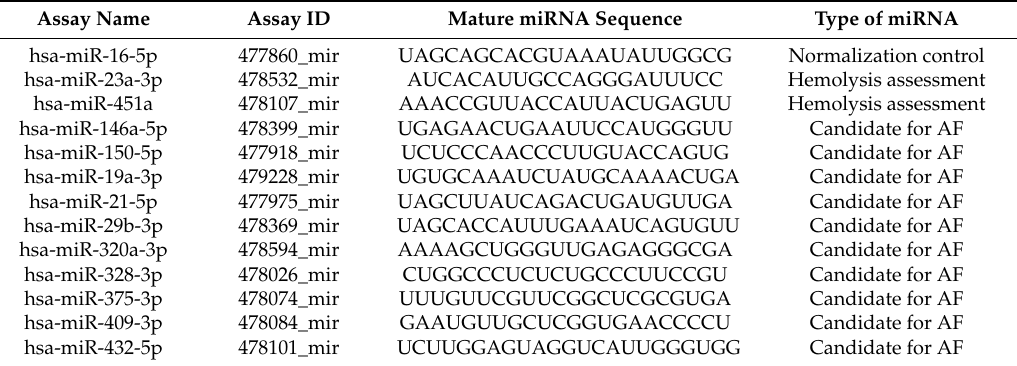
Table 5. List of the miRNA assays used for qPCR. Assay IDs are given for TaqMan Advanced miRNA assays (Thermo Fisher Scientific, Waltham, MA,